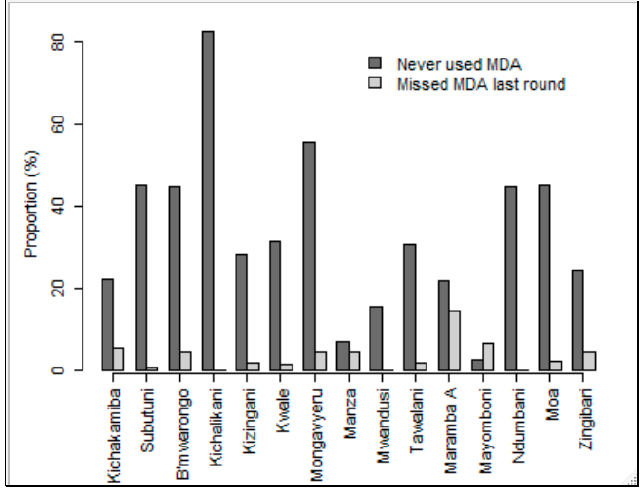
Figure 3. Proportion compliance of villages with mass drug administration (MDA) coverage.